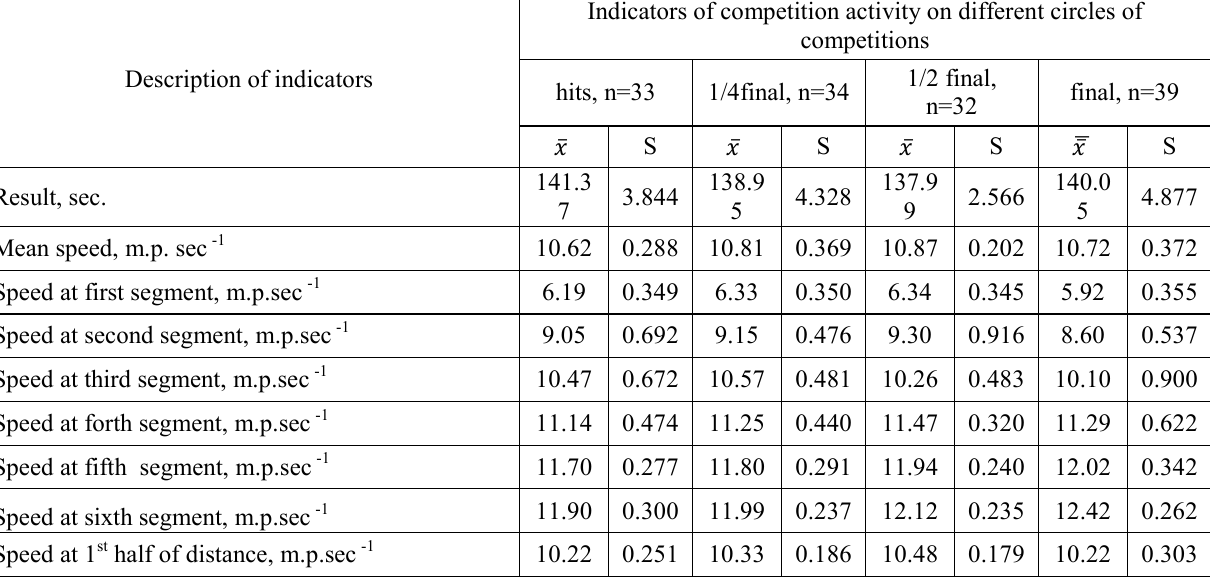
Indicators of competition activity of the world strongest sportsmen in 1500 meters short